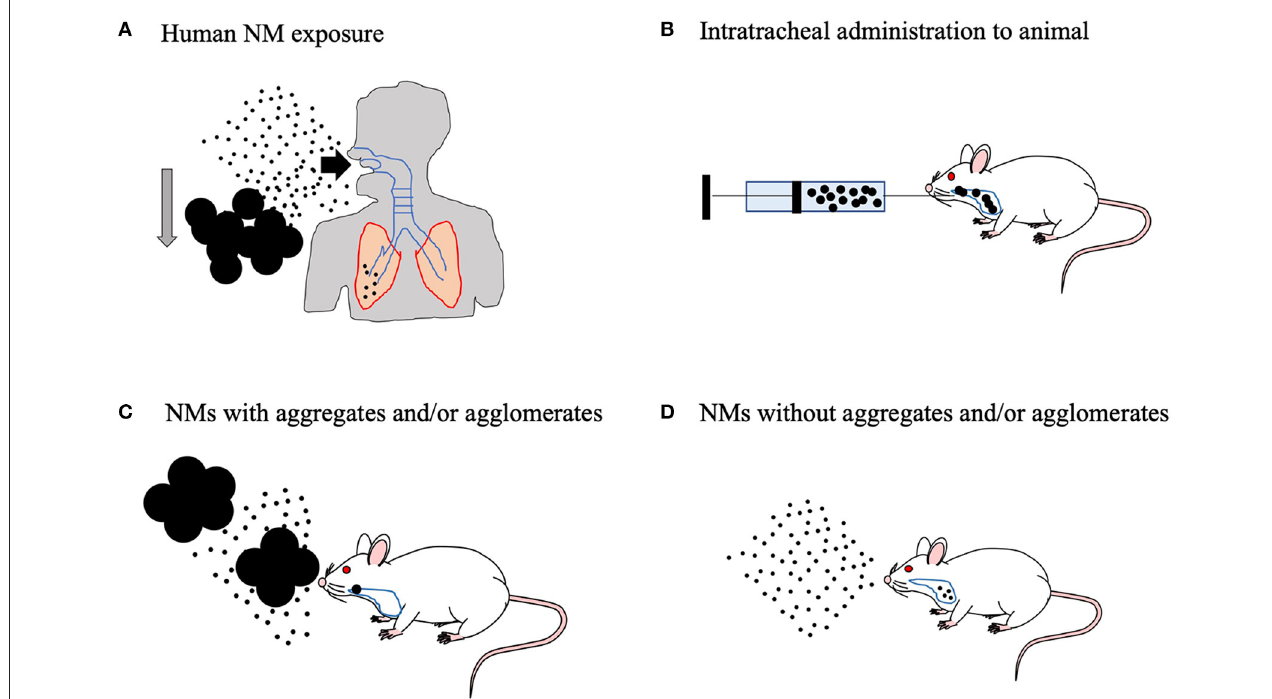
FIGURE 4 | Animal inhalation experiment to predict the effects of human-relevant exposure. (A) The aggregates and/or agglomerates will sediment quickly in ambient air and will be filtered out effectively by the human upper respiratory tract. Humans can be easily exposed to well-dispersed nanomaterials (NMs) in the environment. In fact, human exposure to well-dispersed NMs can result in alveolar lesions. (B) Therefore, suspension of the NMs in biological fluid with aggregates and/or agglomerates does not show the full extent of the effects of NMs on experimental animals. (C) On the other hand, in practical inhalation studies on experimental animals, even though the air in the animal chamber is rigorously agitated to ensure homogeneity of the aerosols, NMs with aggregates and/or agglomerates can enter the respiratory tract of the animal, which makes nanotoxicity evaluation difficult. (D) To address this problem, we developed aerosolized, well-dispersed NMs without aggregates, and/or